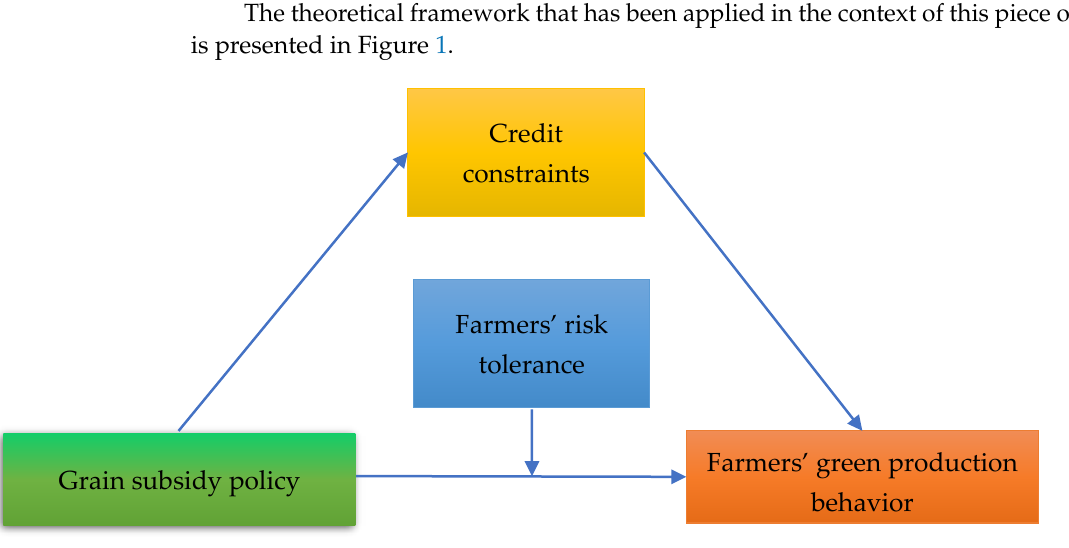
Figure 1. The Theoretical Framework.